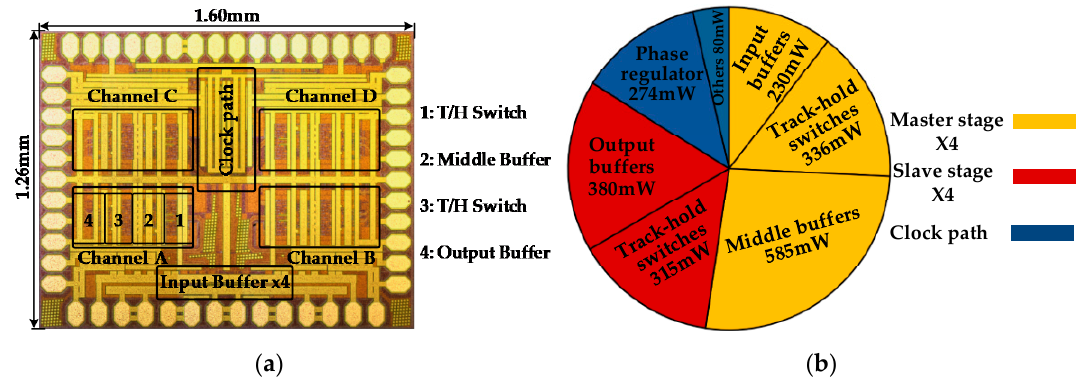
Figure 9. ( a ) Chip microphotograph; ( b ) power breakdown.